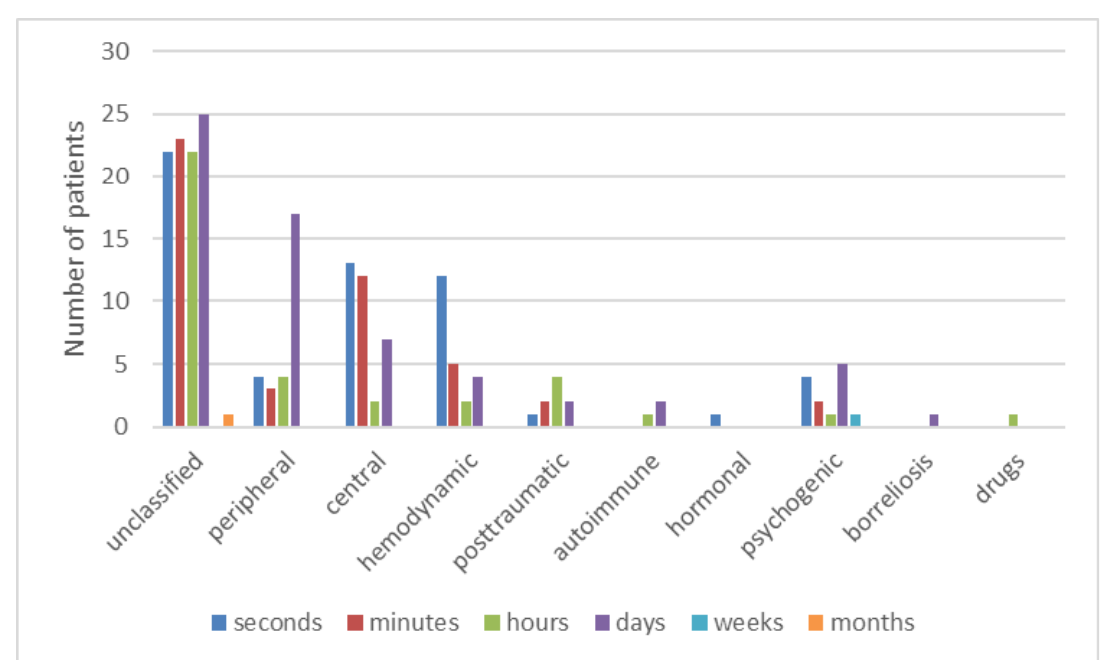
Figure 7. Duration of vertigo and dizziness symptoms stratified by its etiology.